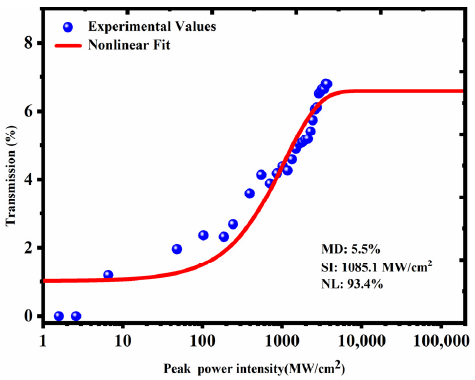
Figure 1. Schematic diagram of the Yb-doped fiber laser.